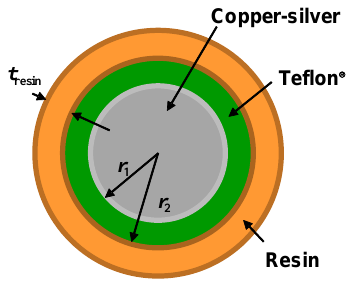
Table 2. Geometric dimensions of the cables.